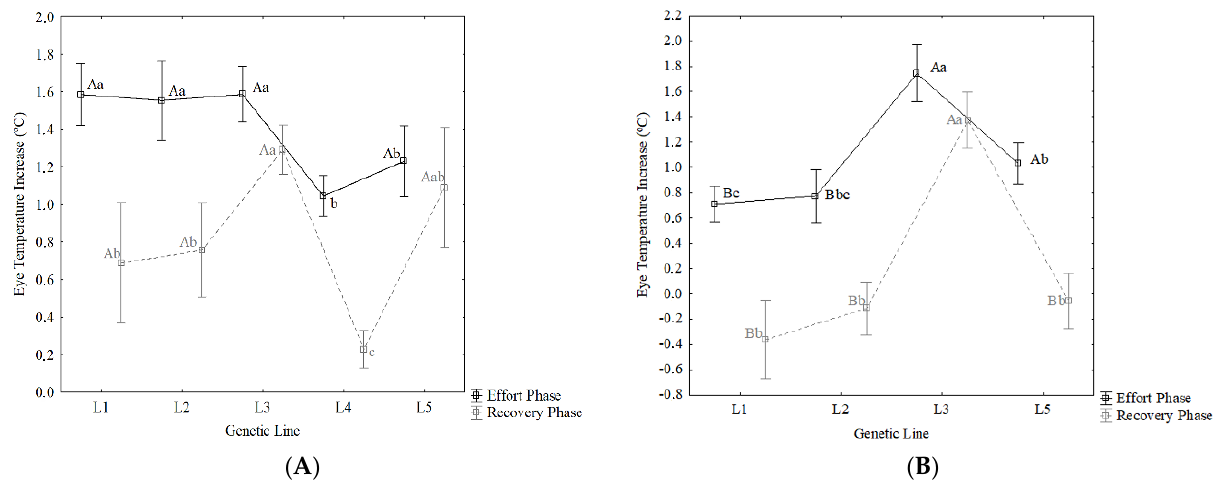
Figure 2. Least square means analysis (means ± standard deviation) according to sex and genetic line and post-hoc Duncan’s test between means. ( A ) Stallions and ( B ) mares. Where L1 is the German genetic line; L2 is the Thoroughbred genetic line; L3 is the Trotter genetic line; L4 is the Pura Raza Española genetic line; and L5 is the Other Breeds genetic line. Different capital letters indicate statistically significant differences ( p < 0.05) between sexes and within variables, whereas different lowercase letters indicate statistically significant differences ( p < 0.05) between genetic lines and within variables.